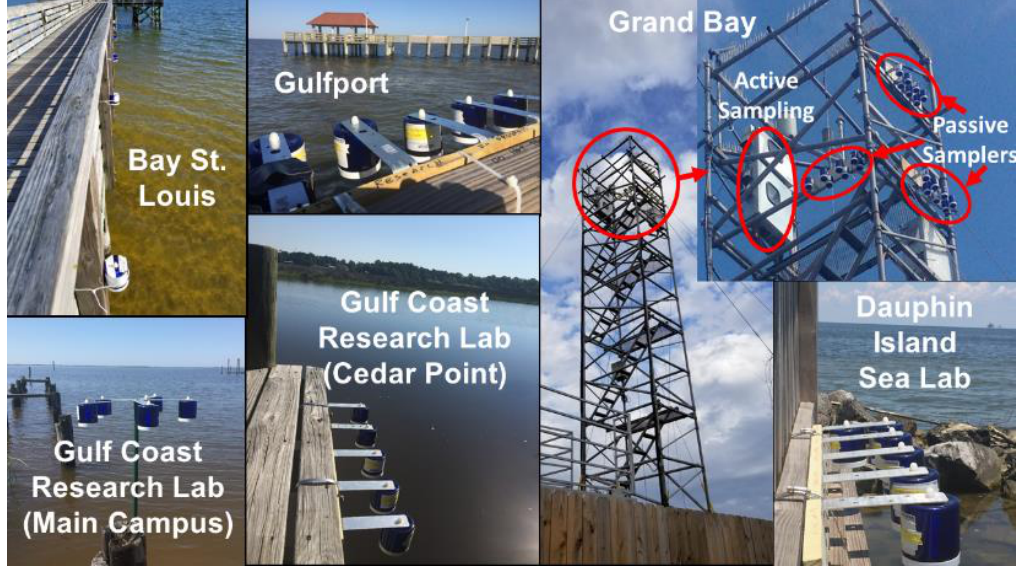
Figure 2. Views of the six sampling sites along the northern Gulf of Mexico (nGoM) showing deployment of passive air samplers for GEM collection. of passive air samplers for GEM